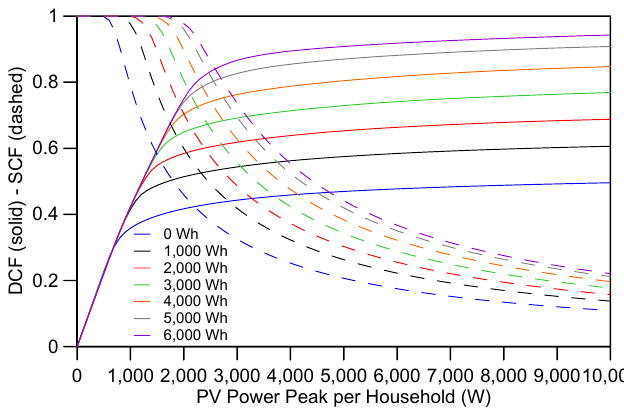
Figure 10. Annual DCF (solid lines) and SCF (dashed lines) variation with the installed PV power and storage capacity per household.